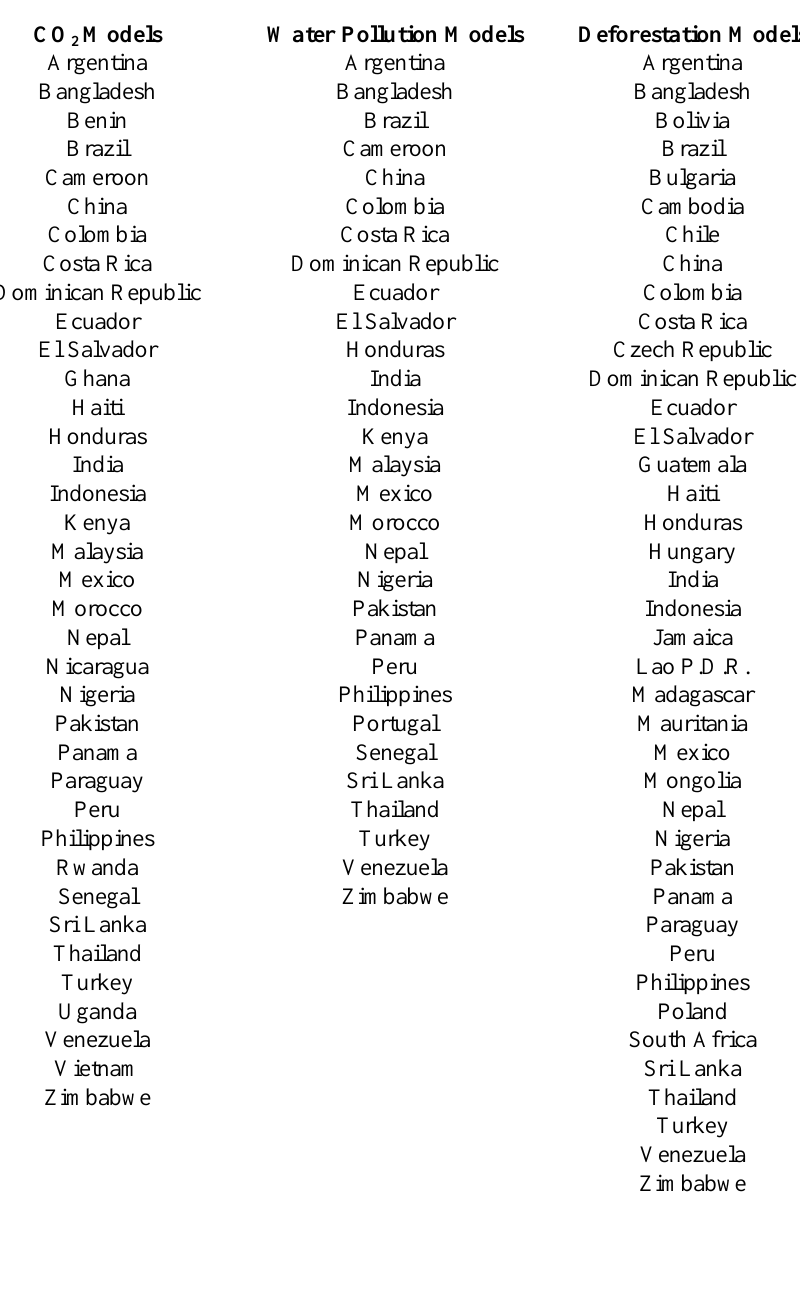
Table 1. Countries Included in the